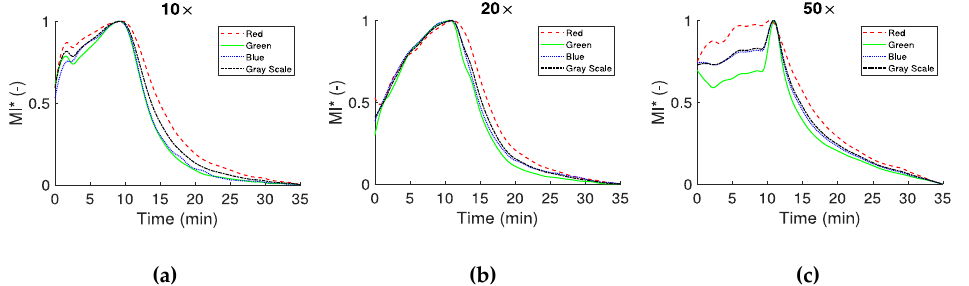
Figure 5. Normalized mean intensity MI ∗ of the RGBGs responses for the three different magnifications (10 × in panel ( a ), 20 × in panel ( b ) and 50 × in panel ( c )). The maximum value of MI is used for the normalization.